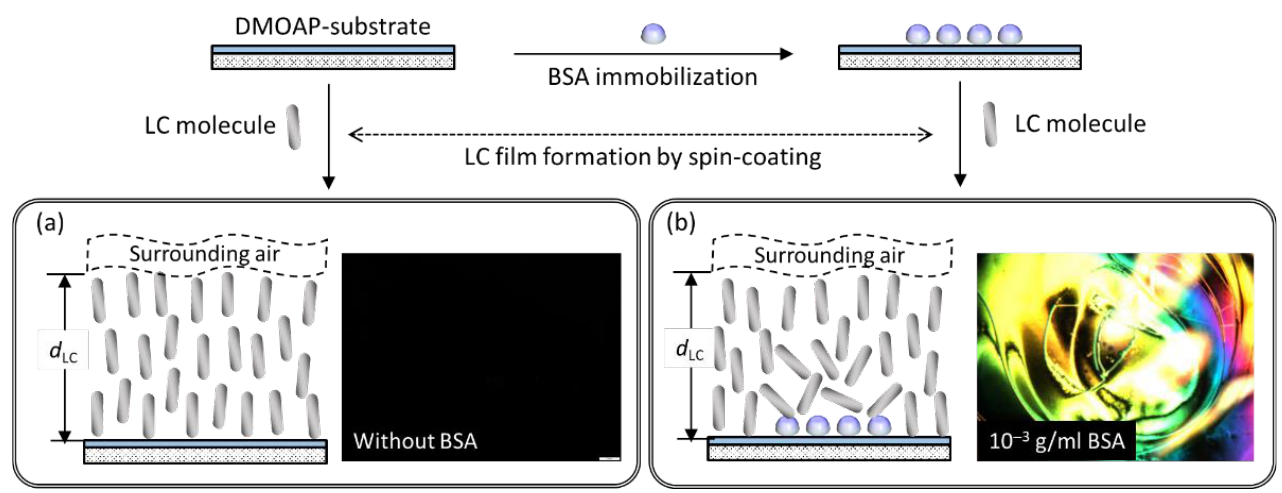
Figure 2. Schematic of the working principle of the LC-based single-substrate protein assay for the detection of BSA with spin-coated LC film on a DMOAP-coated substrate. ( a ) In the absence of BSA, LC molecules are aligned homeotropically, resulting in uniformly dark optical texture. ( b ) In the presence of BSA, LC alignment is disrupted at the LC-glass interface, giving rise to non-uniform and bright optical texture.